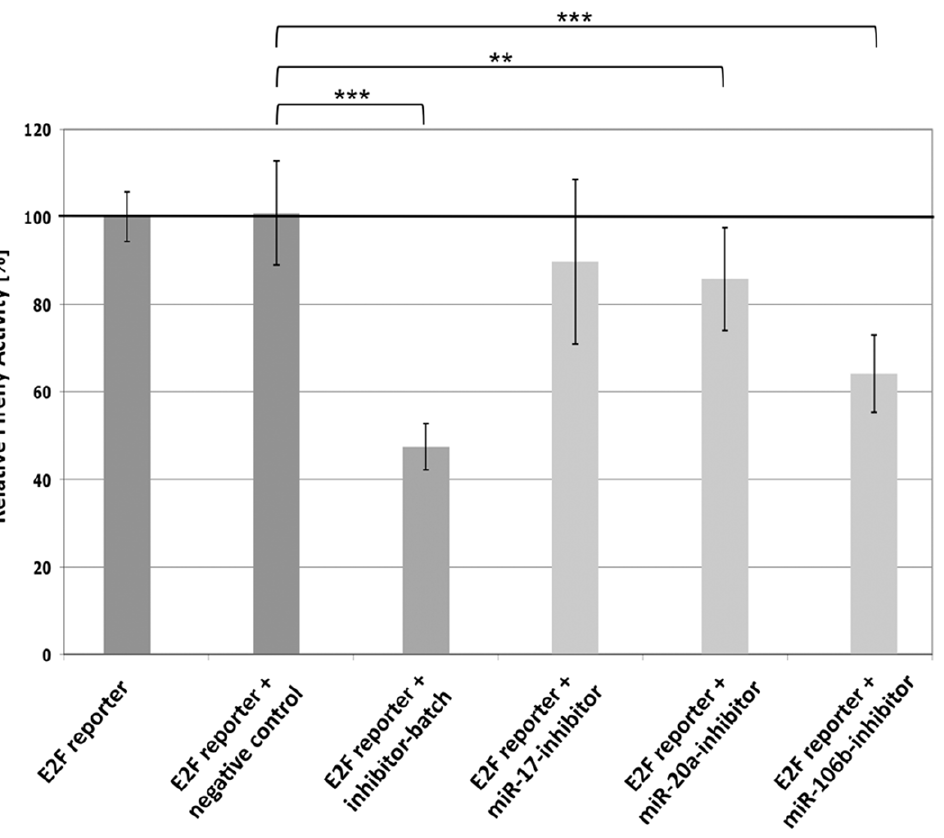
Figure 5. Mir-17, miR-20a, and miR-106b inhibit E2F transcription factor activity. HEK293T-cells were cotransfected with a luciferase reporter vector containing a Firefly gene driven by a minimal promoter consisting of a TATA-box preceeded by a repeat of six E2F-responsive elements and pre-mixed with a CMV-promoter driven Renilla luciferase reporter vector (Cignal Reporter Assay, SABiosciences) and an equimolar batch of miR-17-, -20a-, and -106b-inhibitors as well as with the inibitors alone and with an unspecific negative control respectively. Mean values of normalized Firefly activities from 2 biological experiments, each consisting of 4 technical replicates are shown for each co-transfection. Error bars represent standard deviations and statistical significancies (Student’s t -test, unpaired: ***: p # 0.001, **: p # 0.01) are given. The inhibitor batch strongly reduced E2F-activity, whereas only miR-20a-, and miR-106b-inhibitor alone gave significant effects on E2F-activity.